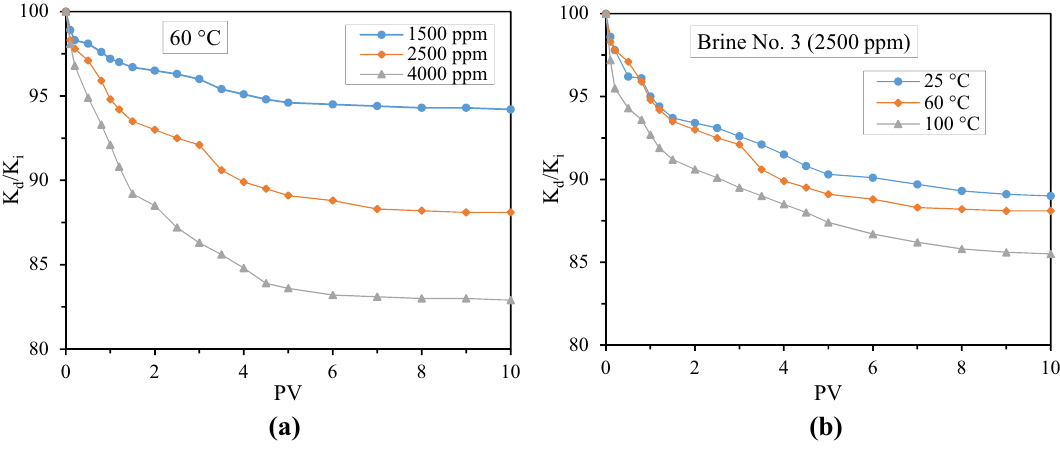
Fig. 4 The changes in the rock permeability during LSWI using various brines ( a ), and brine No. 3 at different temperatures ( b ) in the absence of nanoparticles and scale